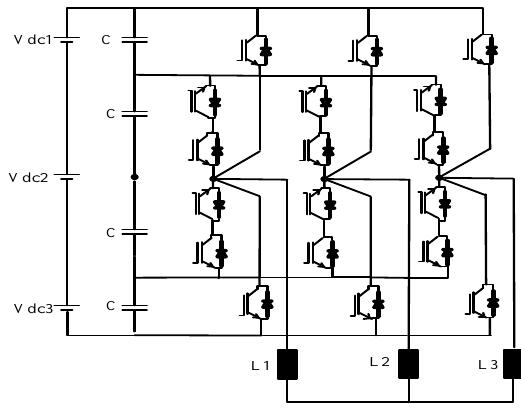
Figure 4. Nested multilevel configuration with four level [18].